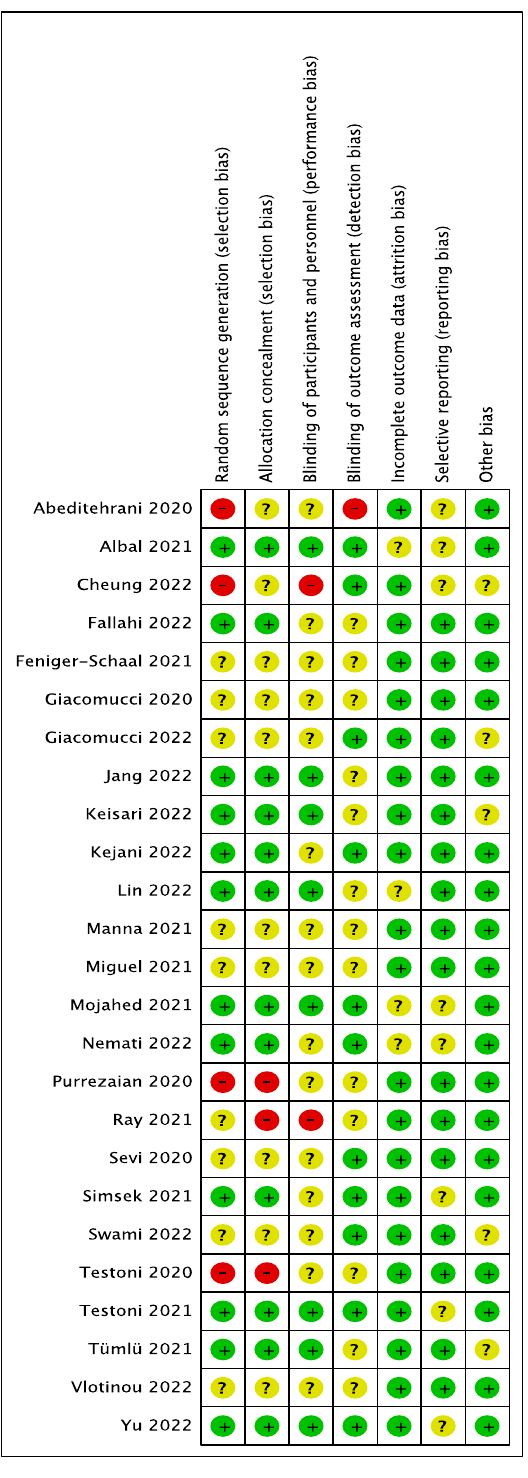
Figure 3. Risk of bias summary for each included study [50–74].